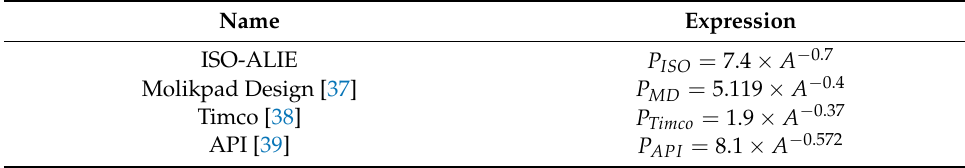
Figure 19. Pressure-area curve obtained in this study and by other researchers. Table 6. Specific formulas for different pressure versus contact area relationships.